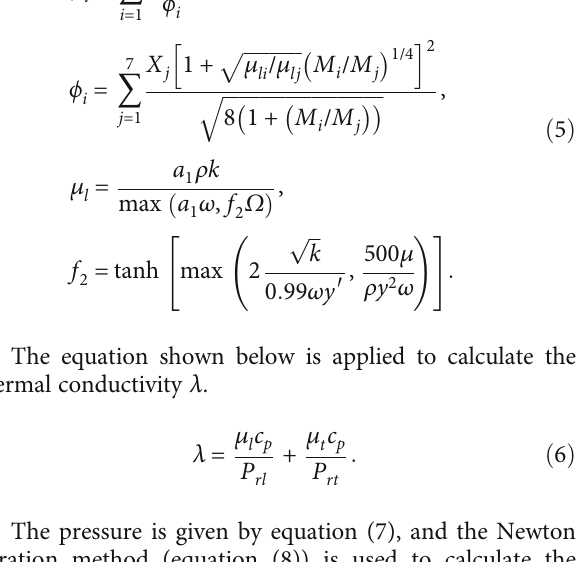
ffiffiffiffiffiffiffiffiffiffiffiffi p μ μ li / lj